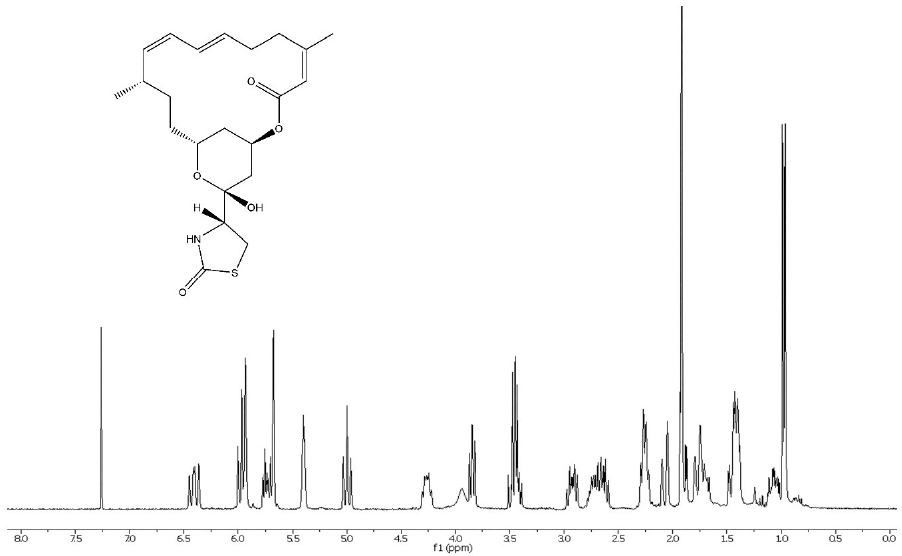
Figure 4. 1 H-NMR spectrum of latrunculin A in CDCl 3 .